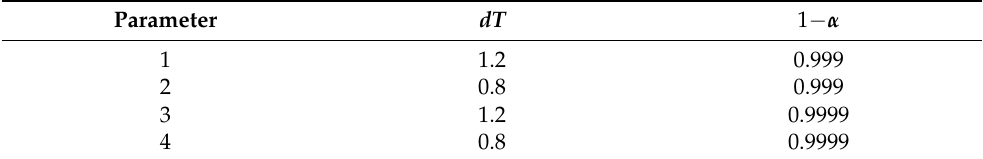
Table 1. Parameters of the TMCF.